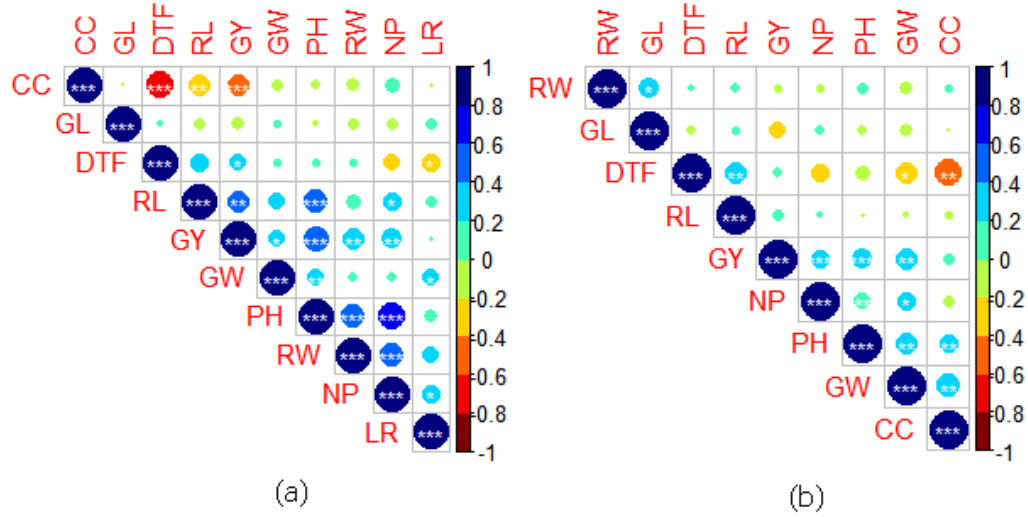
Figure 5. Correlation matrix of traits evaluated. ( a ) MR219 PLs under RS, ( b ) MR219 PLs under NS, Days to 50% flowering (DTF), plant height (PH) in cm, number of panicles (NP), chlorophyll content (CC), leaf rolling (LR), root weight (RW) in g, root length (RL) in cm, grain weight (GW) in g, grain length (GL) in cm, grain yield (GY) in kg ha − 1 . * p < 0.05, ** p < 0.01, ** p < 0.001.